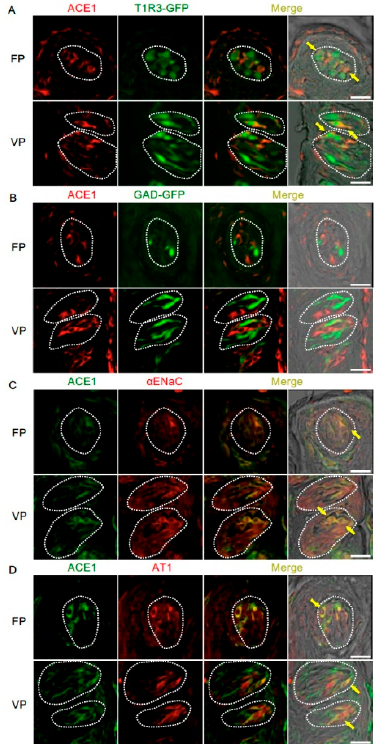
Figure 3. Co-expression of angiotensin-converting enzyme-1 (ACE1) with taste receptor type 1 member 3 (T1R3), glutamate decarboxylase 67 (GAD), epithelial sodium channel α subunit ( α ENaC) or angiotensin II type 1 receptor (AT1) in taste bud cells. ( A ) Expression of ACE1 in fungiform papillae (FP) and circumvallate papillae (VP) of T1R3-green fluorescent protein (GFP) mice. ( B ) Expression of ACE1 in FP and VP of GAD67-GFP mice. ( C ) Co-expression of ACE1 with α ENaC in FP and VP of B6 mice. ( D ) Co-expression of ACE1 with AT1 in FP and VP of B6 mice. Immunostaining for ACE1 is shown in red ( A , B ) or green ( C , D ). GFP fluorescence in T1R3-GFP and GAD67-GFP mice is shown in green ( A , B ). Immunostaining for α ENaC and AT1 is shown in red ( C , D ). The last merge panels: Nomarski images were overlaid with immunofluorescence (or GFP) merge images. Arrows indicate ACE1-expressing taste cells that co-express T1R3, α ENaC, or AT1. Dotted lines indicate the outlines of taste buds: scale bar, 25 µ